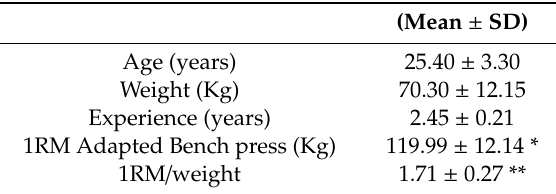
Table 1. Characterization of subjects.